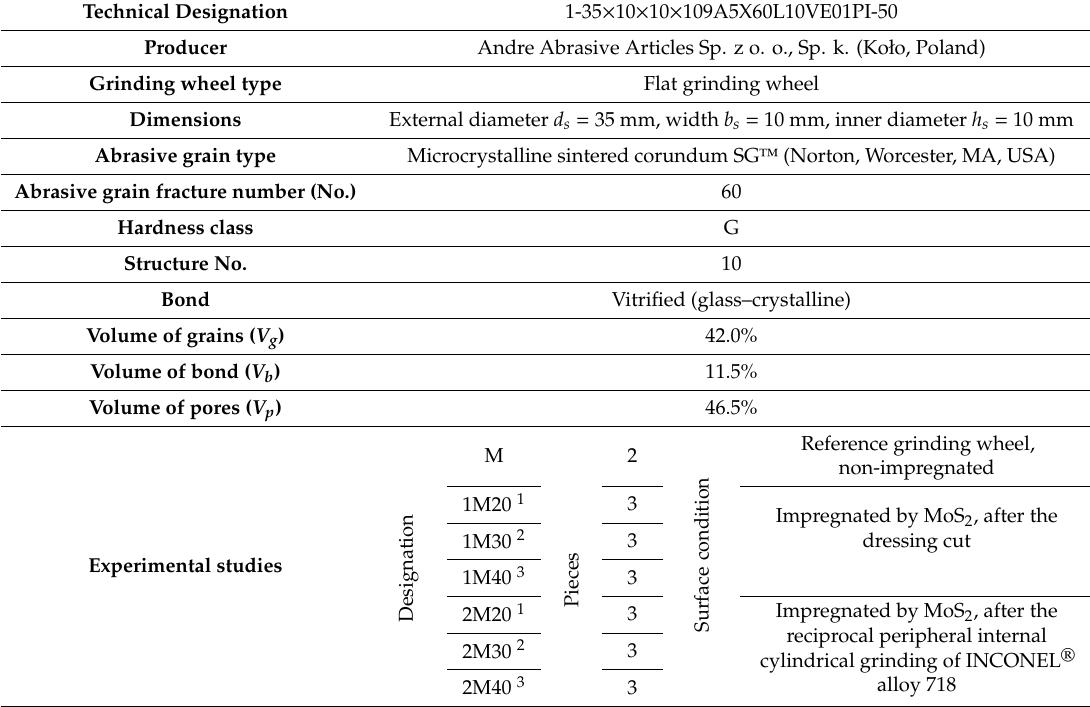
Table 2. General characteristics of the grinding wheels used in the experimental